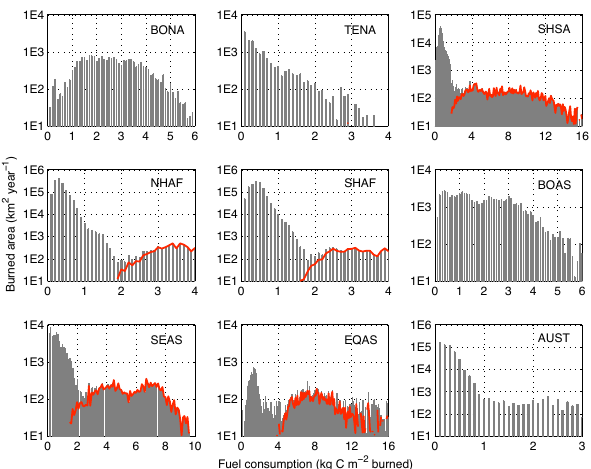
Fig. 5. Frequency distribution of fuel consumption in different regions (See Fig. 7 for the list of region abbreviations), with deforestation fires marked in red. Note the logarithmic y-axis scale and the different x-axis scales for each plot. Each bar represents 0.1 kg C per m 2 of burned area, averaged over 1997-2009, centered upon its mean.